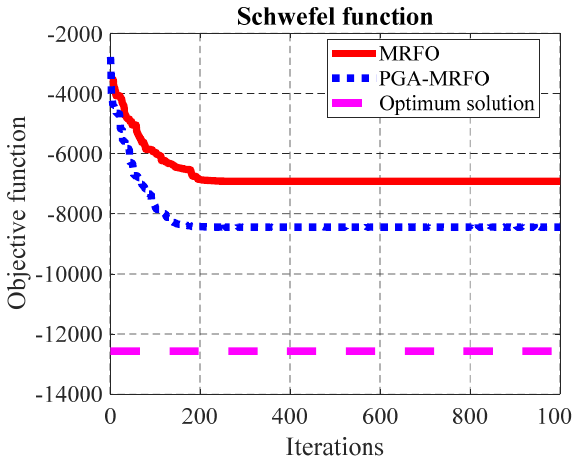
Figure 4. Converges curves for F 8 .